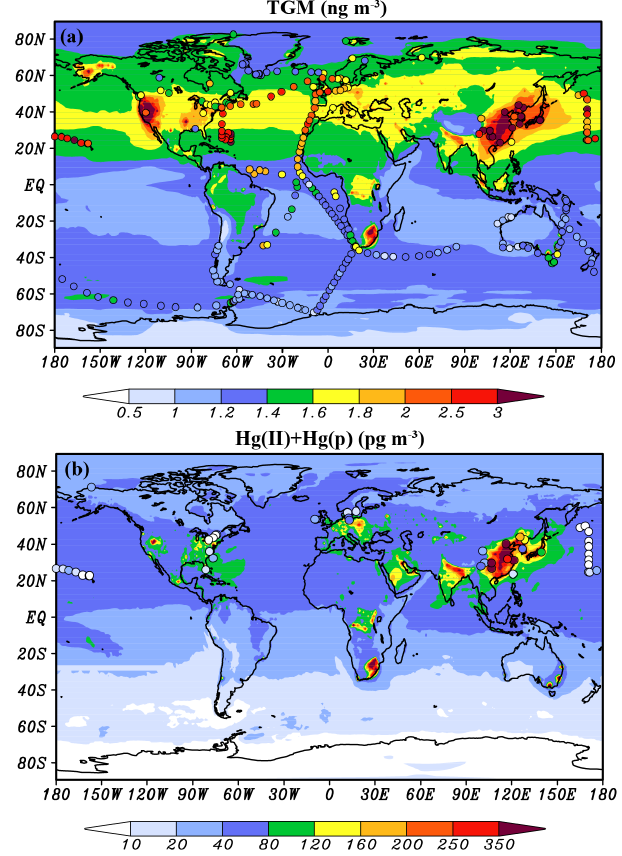
Figure 3. Annual average TGM (a) and oxidized mercury Hg(II) + Hg(P) (b) concentrations in surface air. Model results (background, for year 2001) are compared to observations (cir- cles) from long-term surface sites and short-term ship cruises. Units of TGM and oxidized mercury are nanograms per cubic meter (ngm − 3 ) and picograms per cubic meter (pgm − 3 ), respectively.